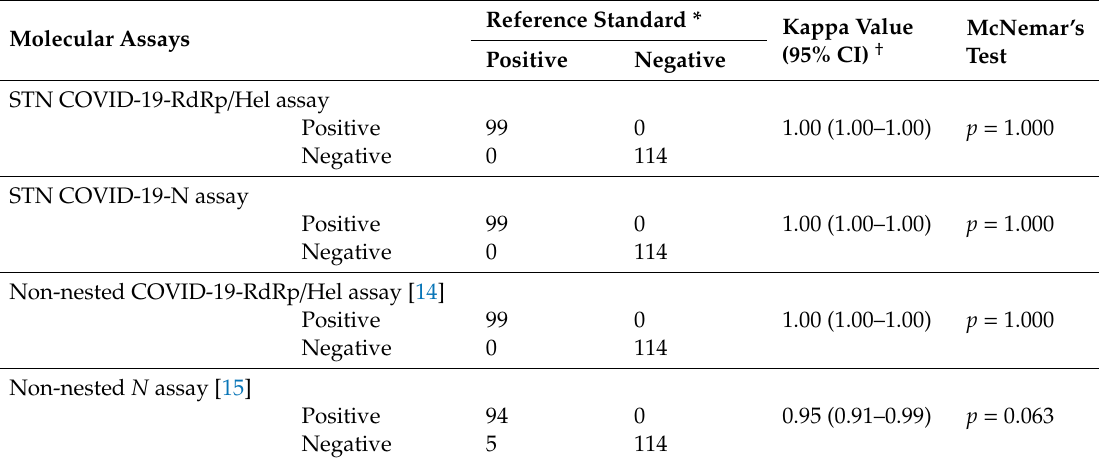
Table 1. Clinical performance comparison of the in-house developed STN real-time RT-PCR assays and other validated molecular assays for SARS-CoV-2